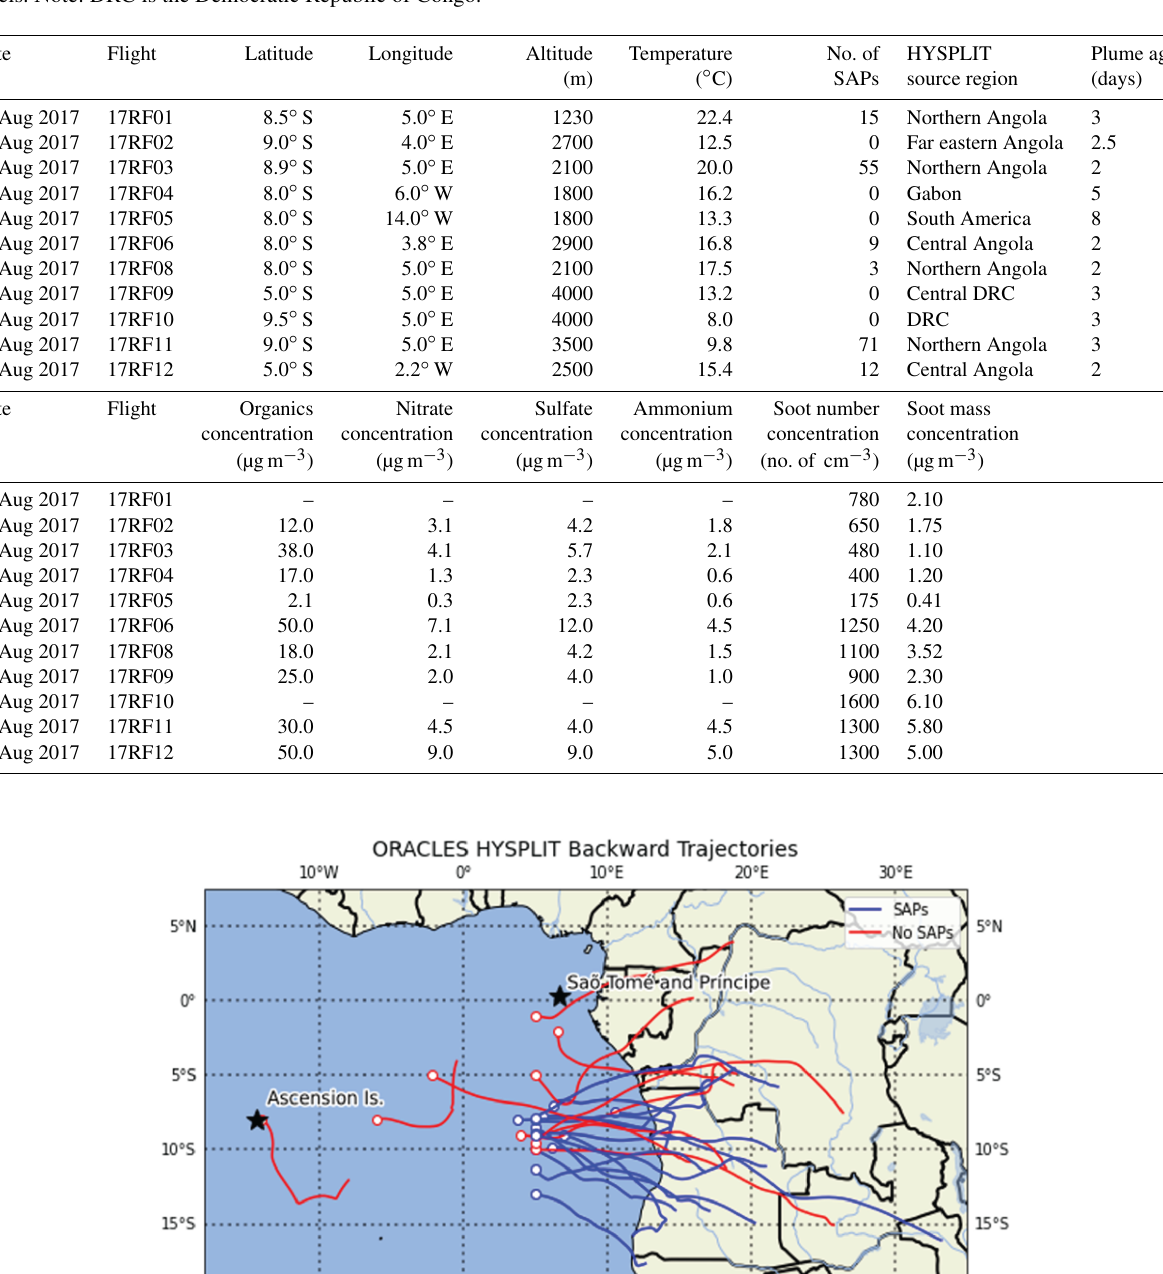
Table 1. The 2017 research flights were conducted between 12 and 31 August 2017. All concentrations and temperature values are 5min averages. Some data values were not available and were left blank. Soot number and mass concentrations were obtained from the single particle soot photometer (SP2). Organics, nitrates, sulfates, and ammonium were obtained from the aerosol mass spectrometer (AMS). Plume age was determined from Hybrid Single-Particle Lagrangian Integrated Trajectory (HYSPLIT) and Weather Research and Forecasting (WRF) models. Note: DRC is the Democratic Republic of Congo.